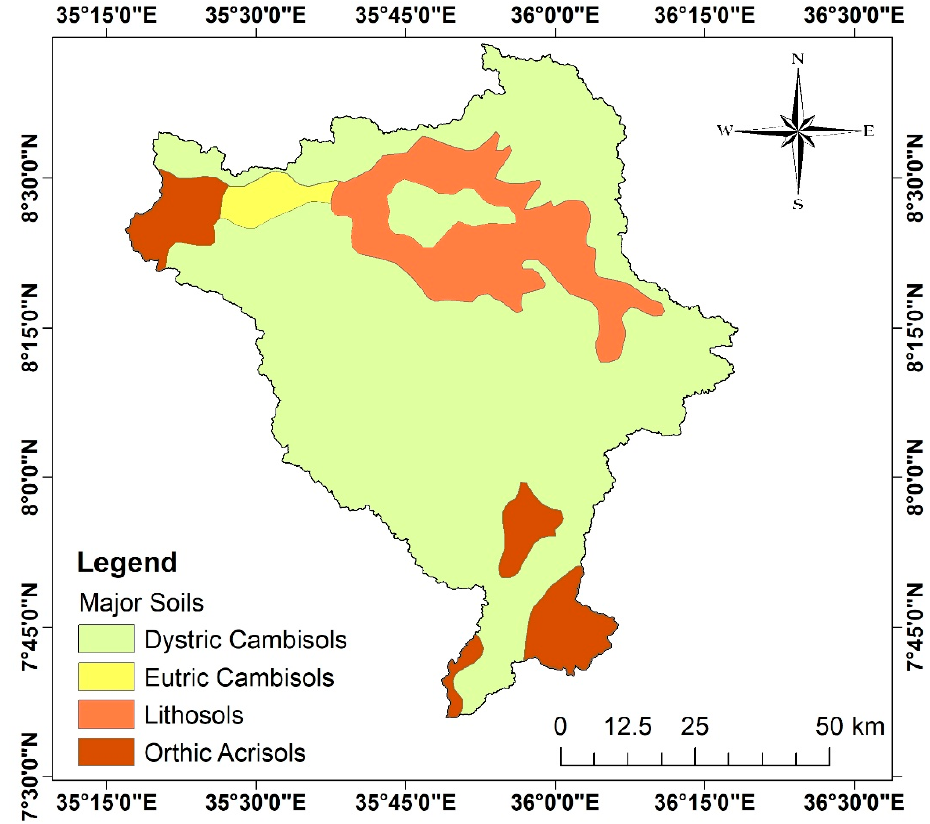
Figure 4. Major soils map of the watershed (modified from UNDP and FAO, 1984).